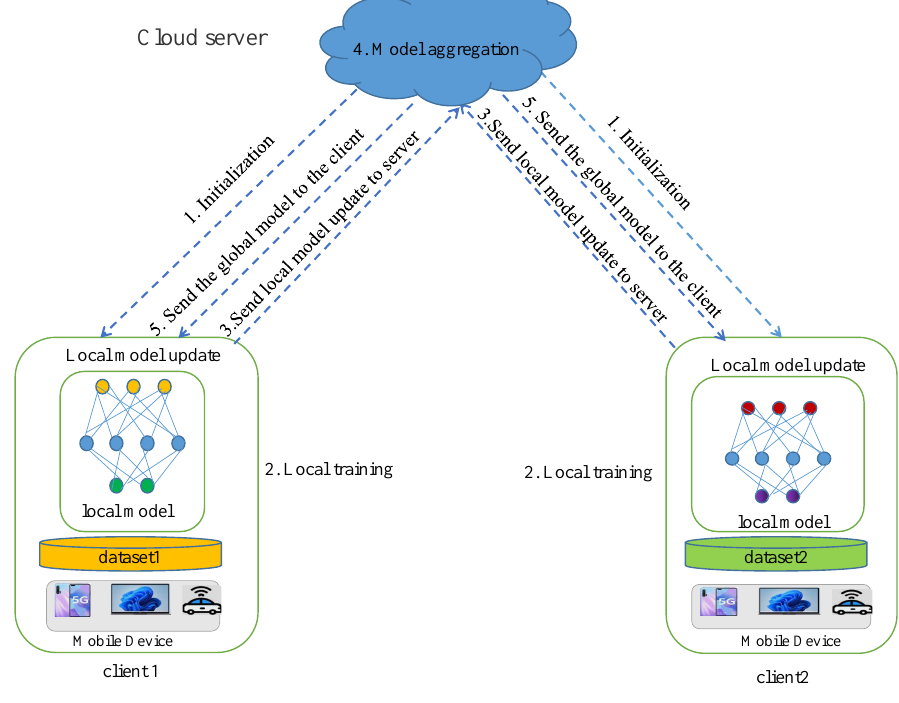
Figure 2. Training process of federated